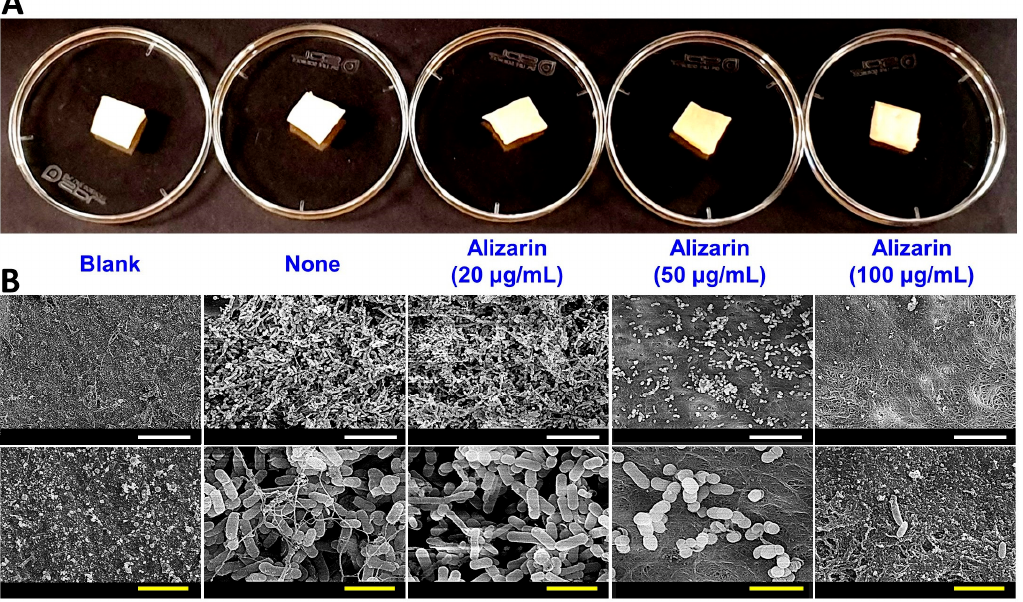
Figure 7. Effects of alizarin on biofilm development by C. acnes on porcine skin. Antibiofilm activities of alizarin against biofilm formation on porcine skin ( A ) were assessed by SEM ( B ) after 7-day culture under anaerobic conditions. White and yellow scale bars indicate 20 and 4.29 µm, respectively ( B ).